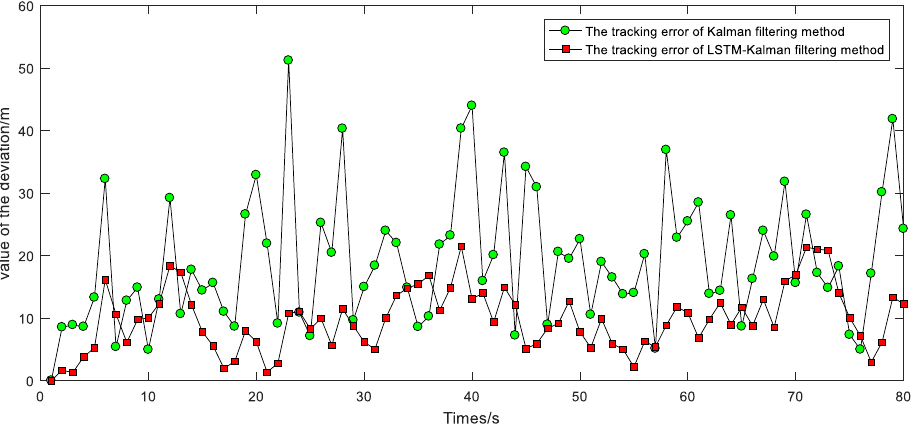
Figure 11. Comparison diagram of the target tracking deviations between the Kalman filtering method and the LSTM–Kalman filtering method.